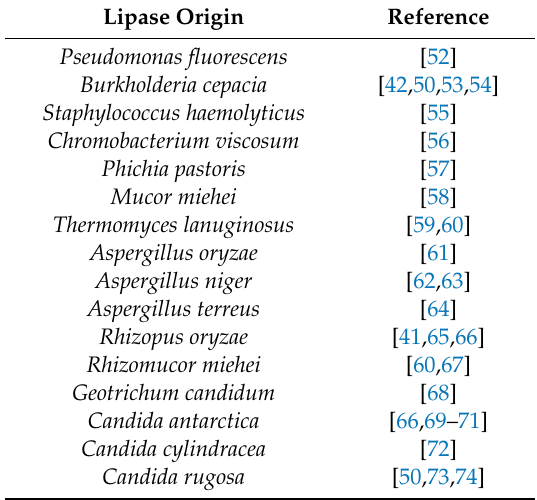
Table 1. Bacteria, yeasts and filamentous fungi producing lipase and sources of